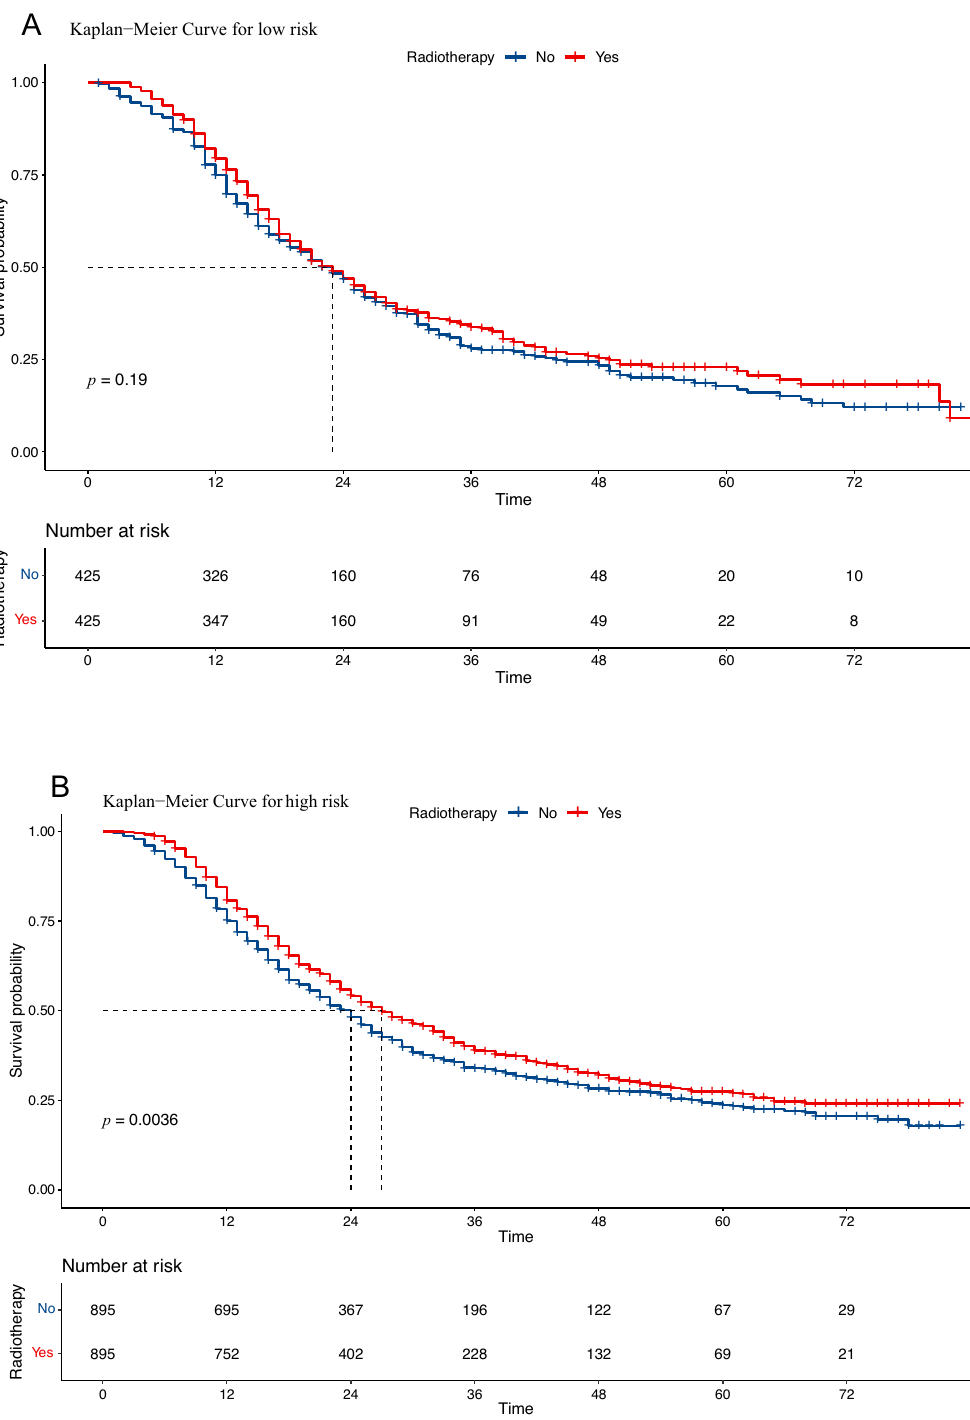
Figure 7. ( A ) Overall survival of pancreatic cancer patients with or without radiotherapy in the low ‐ risk group; ( B ) Overall survival of pancreatic cancer patients with or without radiotherapy in the high ‐ risk